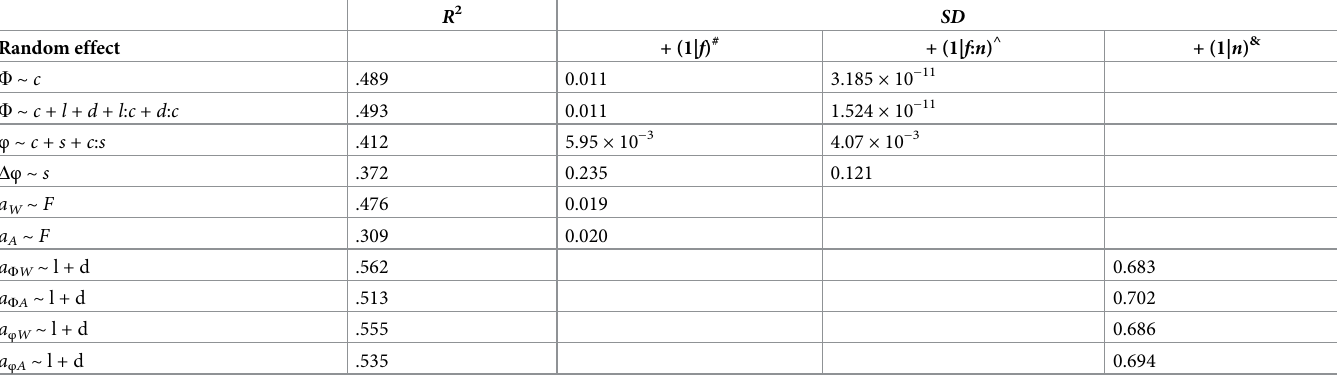
Table 2. Linear mixed effects model fit (adjusted R 2 ) and standard deviation ( SD ) of random effects.